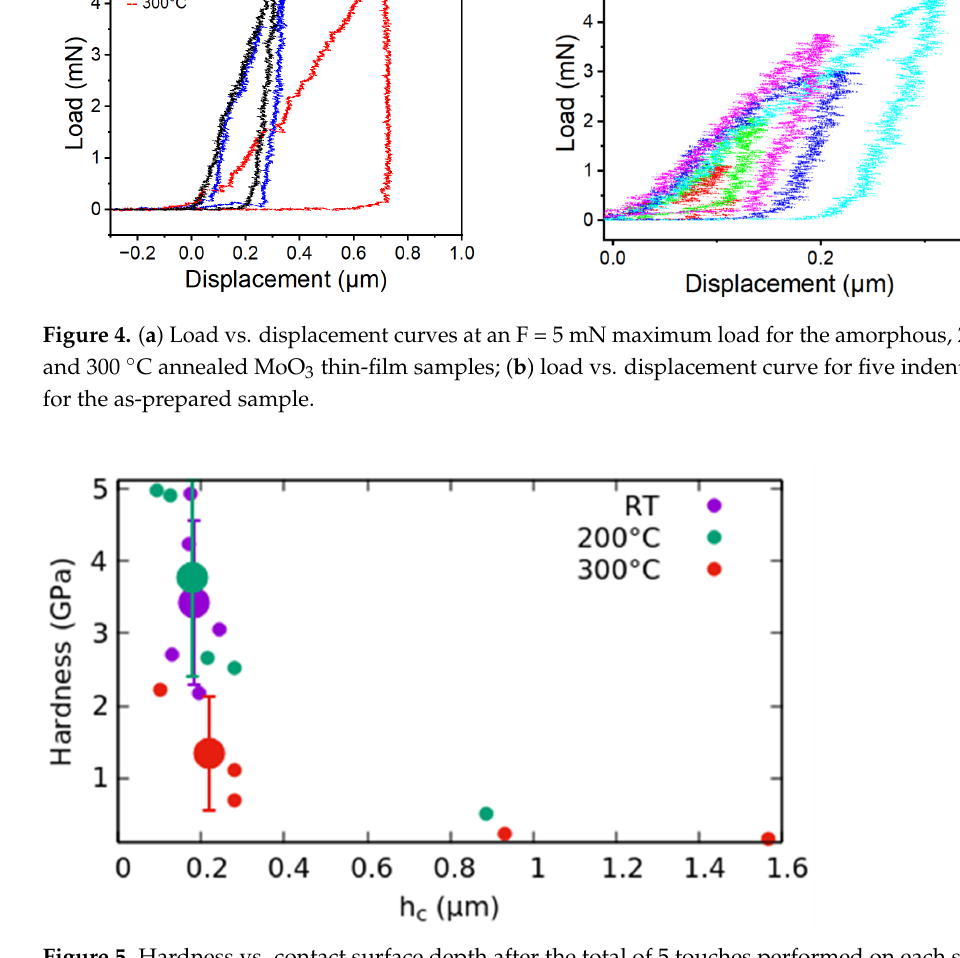
Figure 5. Hardness vs. contact surface depth after the total of 5 touches performed on each sample. The huge squares represent the average of the hardnesses whose displacements are below 0.4 um to eliminate the deterministic effect of the substrate.